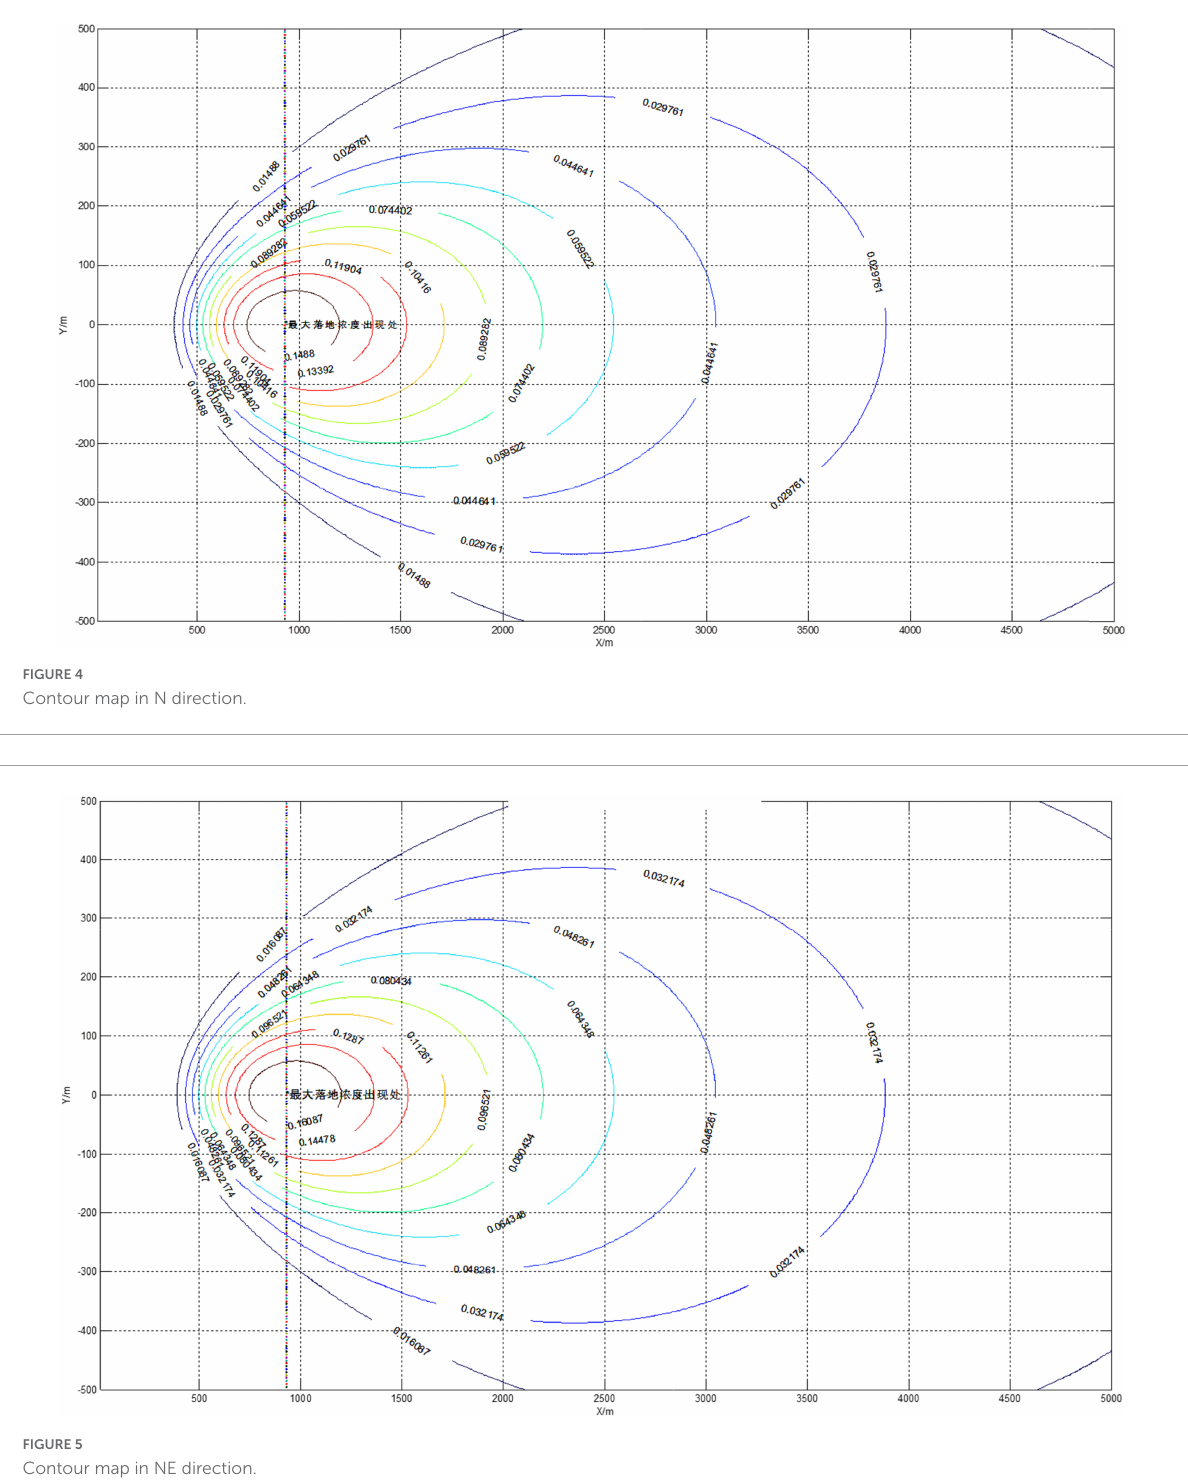
FIGURE5 Contour map in NE